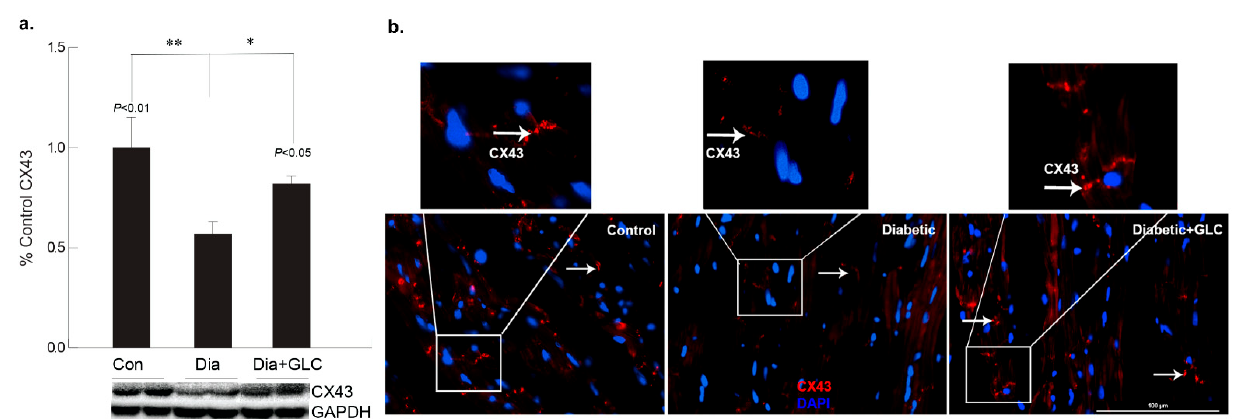
Figure 2. GLC alleviated the expression of gap junction protein connexin-43 in cardiac tissue of Type 2 diabetic rats. Gap junction protein connexin43 (Cx43) expression was assessed by Western blot analysis as well as by immunohistochemistry in ZDF type 2 diabetic, diabetic with GLC treatment and lean control rats. ( a ) Western blot analysis demonstrated a decrease in CX43 expression in the ventricular cardiac tissue of diabetic animals was noted compared to the lean control animals, ** p < 0.01; GLC treated cardiac tissue exhibited restoration of CX43 expression in the diabetic with GLC treated group compared to the diabetic only group * p < 0.05. ( b ) Immunohistochemical analysis also exhibited reduced CX43 expression in diabetic animals whereas GLC treated animals displayed improved CX43 expression; arrows indicate CX43 positive staining in red (Scale bar = 100 µm).